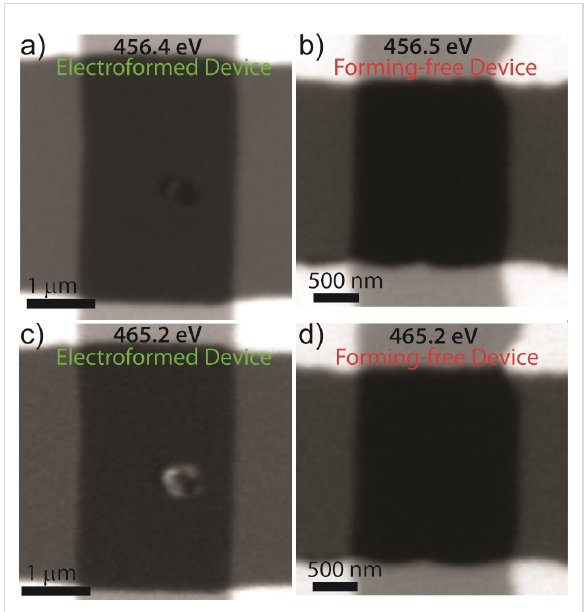
Figure 2: Comparison of scanning transmission X-ray micrographs for electroformed and forming-free devices. Contrast was derived from spatially-resolved X-ray absorption using incident monochromatic X-rays at the indicated energy which is before (456.4/456.5 eV) and within (465.2 eV) the main Ti L 3 edge. For the electroformed device, (a) and (c), a strong contrast was observed within the junction which reversed at the different X-ray energies, and corresponds to the forma- tion of a sub-oxide phase. No such contrast was observed within the junction of the forming-free devices, (b) and (d). More detailed X-ray absorption spectroscopy for these junction regions are shown below in Figure 3.